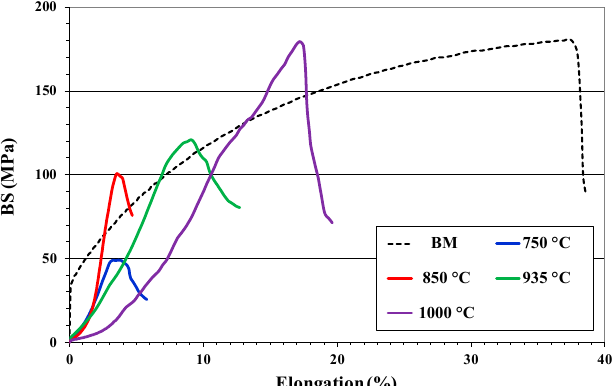
Figure 7. Bonding strength of the Cu-Cu bond in relation to the bonding temperature (processing for 90 min); BM: base material.